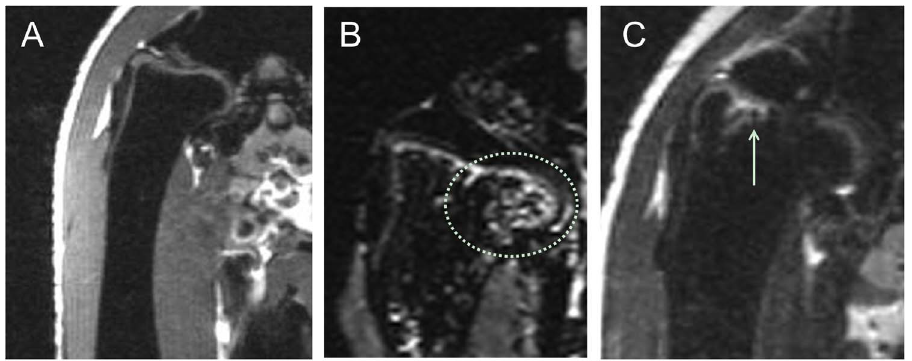
Figure 1. Representative T2-weighted coronal MRI images of an emu in SAON group. (A) baseline before SAON-induction; (B) at week 2 post SAON-induction, showing edema (dotted circle) in the proximal femur; and (C) at week 12 post SAON-induction, showing decreased edema (arrow) in the proximal femur. No collapse was found in the first 12 weeks after LPS-MPS induction.